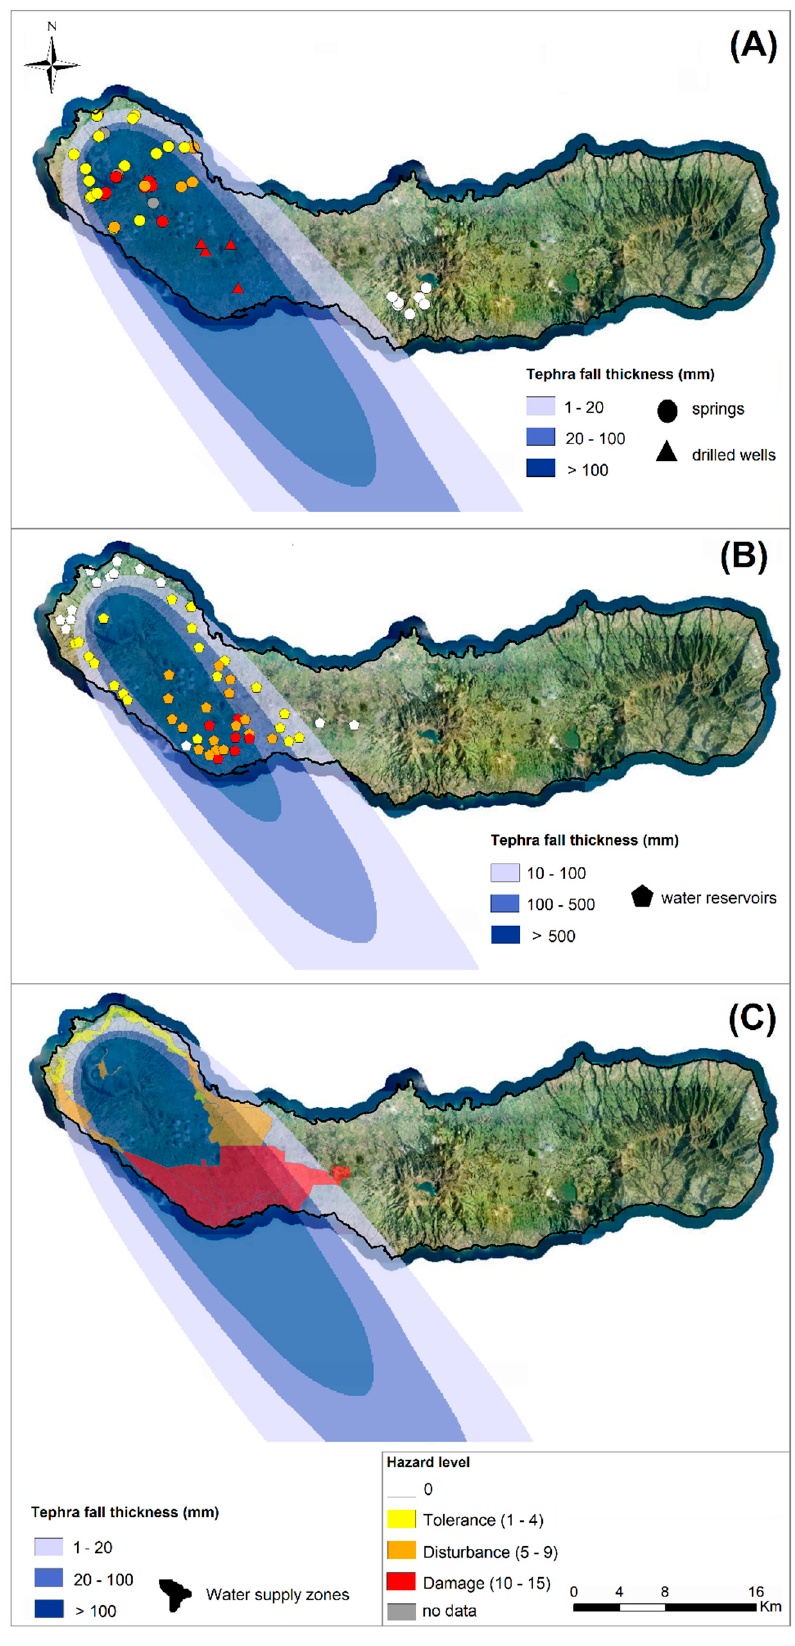
Figure 4. Cartographic representation of the impacts of eruptive scenario B, respectively, for: ( A ) Volume of water being abstracted; ( B ) storage capacity of the reservoirs; ( C ) number of inhabitants being served by the system over the water supply system of Ponta